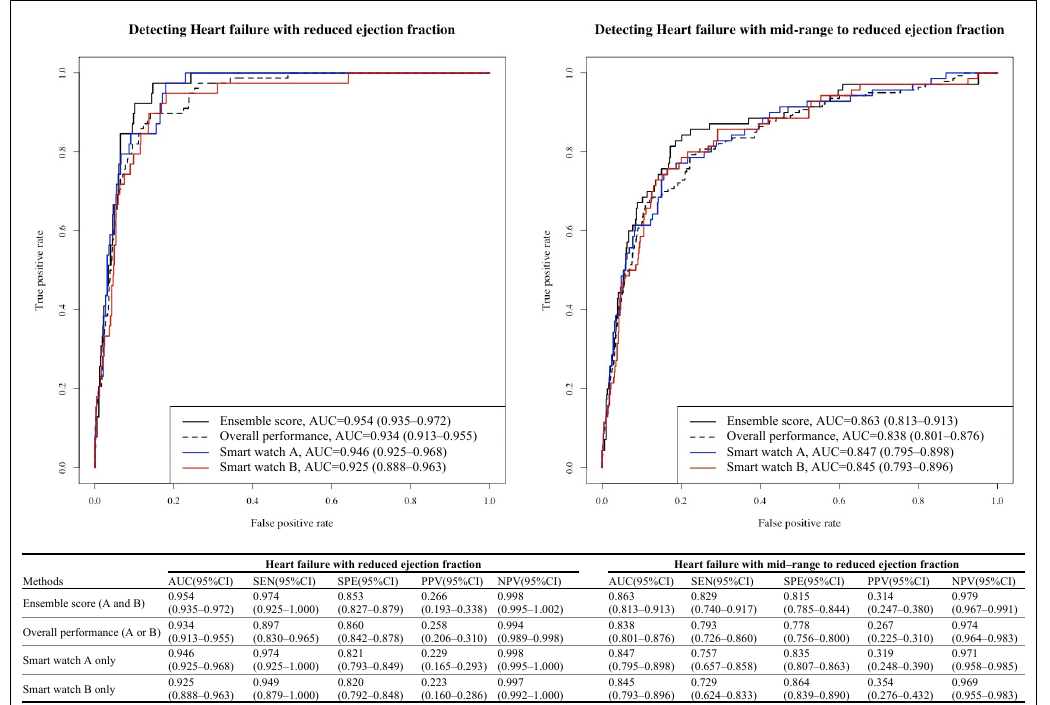
Figure 4. Performance of artificial intelligence for detecting heart failure using smart watch ECG. Legend: AUC denotes area under the receiver operating characteristic curve, CI confidence interval, ECG electrocardiography, NPV negative predictive value, PPV positive predictive value, SEN sensitivity, and SPE specificity.